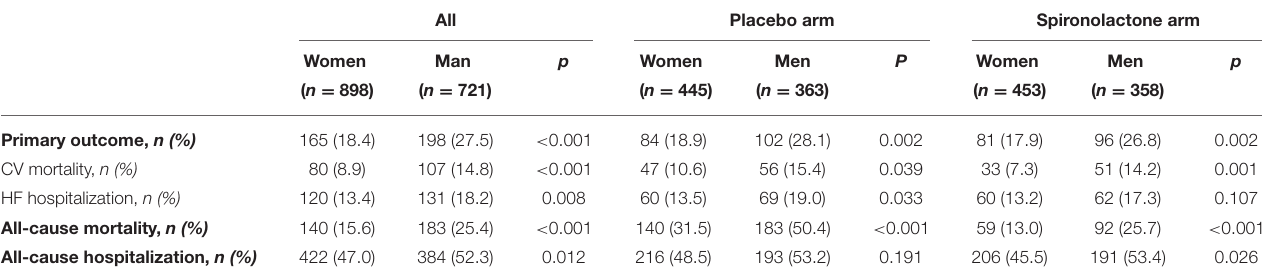
TABLE 2 | Differences in outcomes between women and